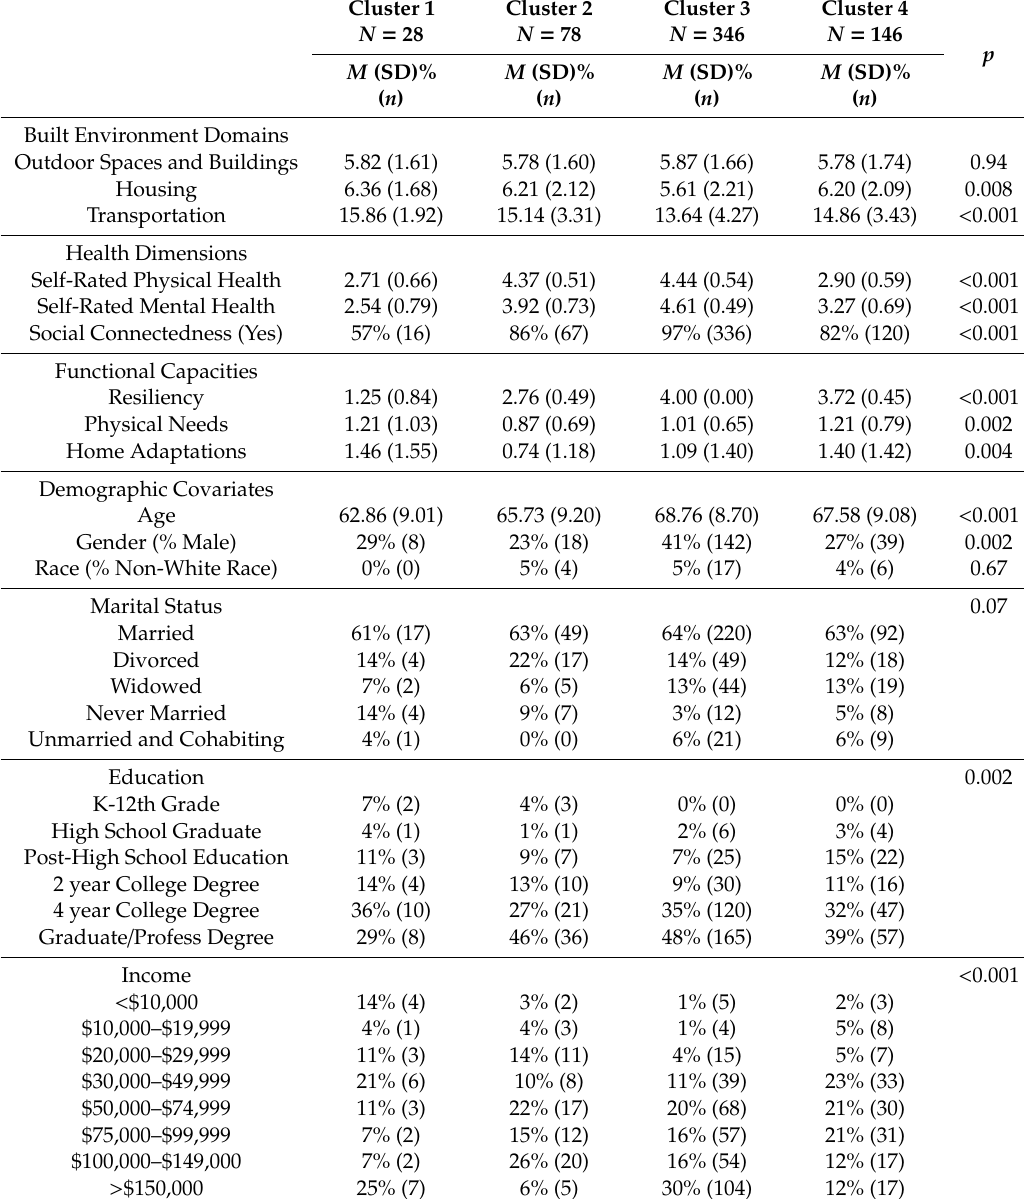
Table 1. Characteristics of community-dwelling older adults ( n = 598) clustered by built environmental domains, heath dimensions, functional capacities and